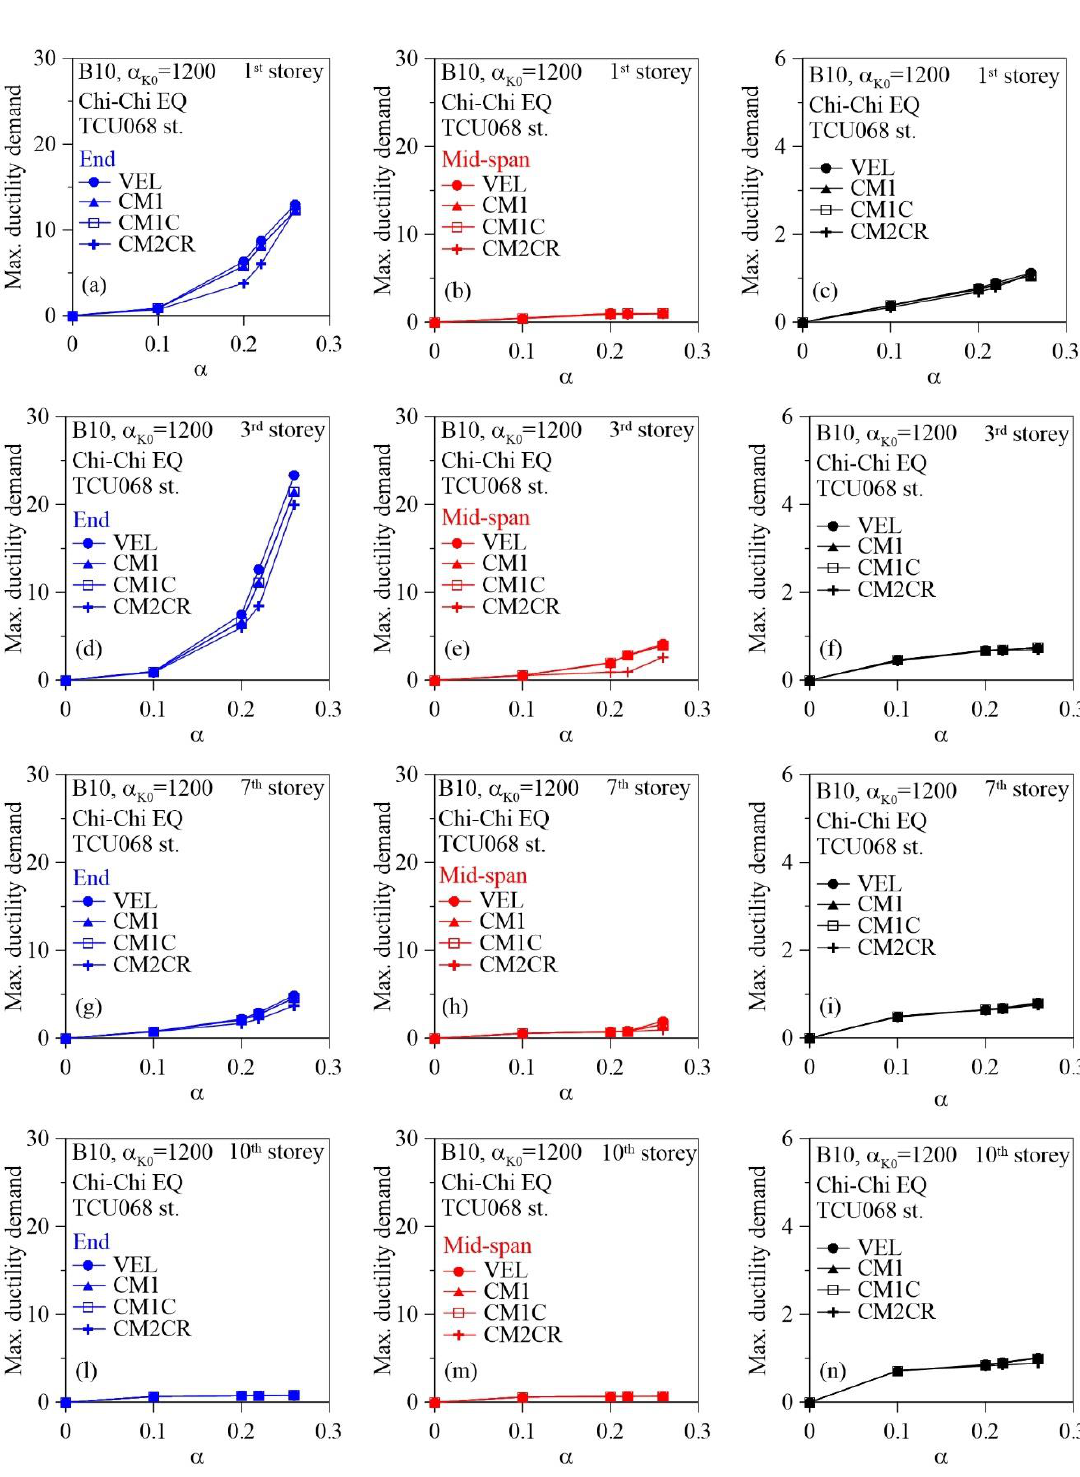
Figure 8. Ductility demands of the B10 structure subjected to the Chi-Chi EQ: end sections ( a , d , g , l ) and mid-span sections ( b , e , h , m ) of beams; end sections ( c , f , i , n ) of columns.